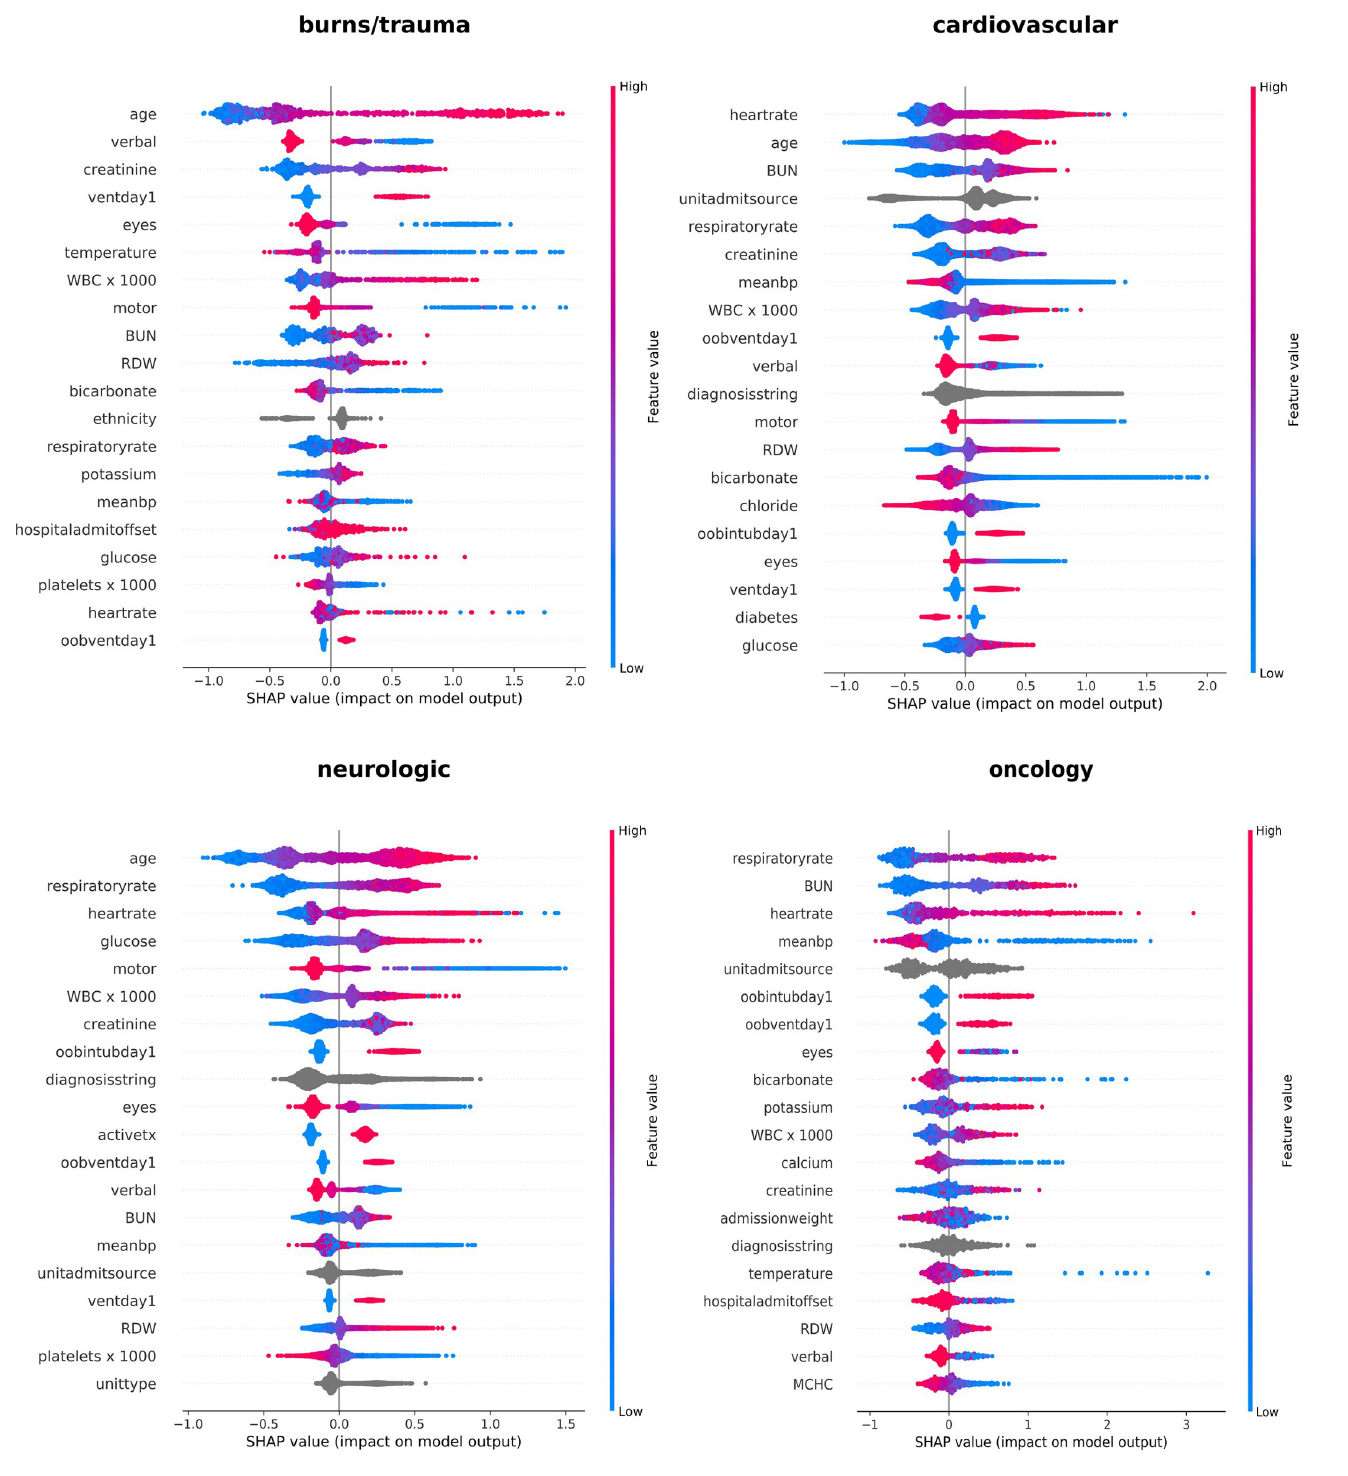
Fig 2. Feature importance plots based on Shapley values for burns/trauma, cardiovascular, neurologic, and oncology disease groups.